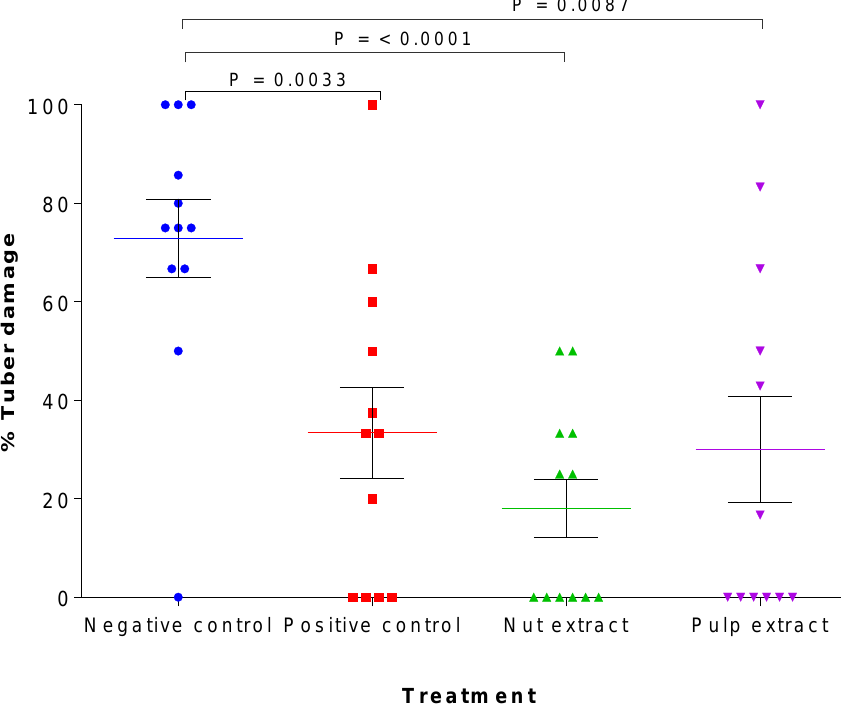
Figure 2. Scatter plot representation of sweet potato tuber damage for various treatments ± SEM with 4 technical repeats and 3 independent biological repeats per treatment. p -values, to indicate significant difference, were determined by the Mann–Whitney test.